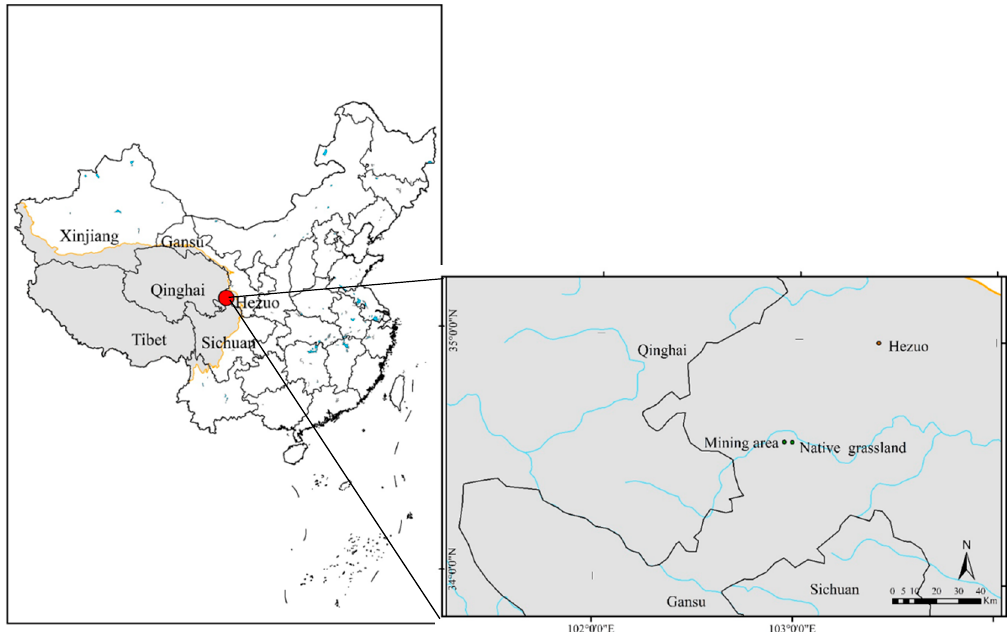
Figure 1. Location of the study area.